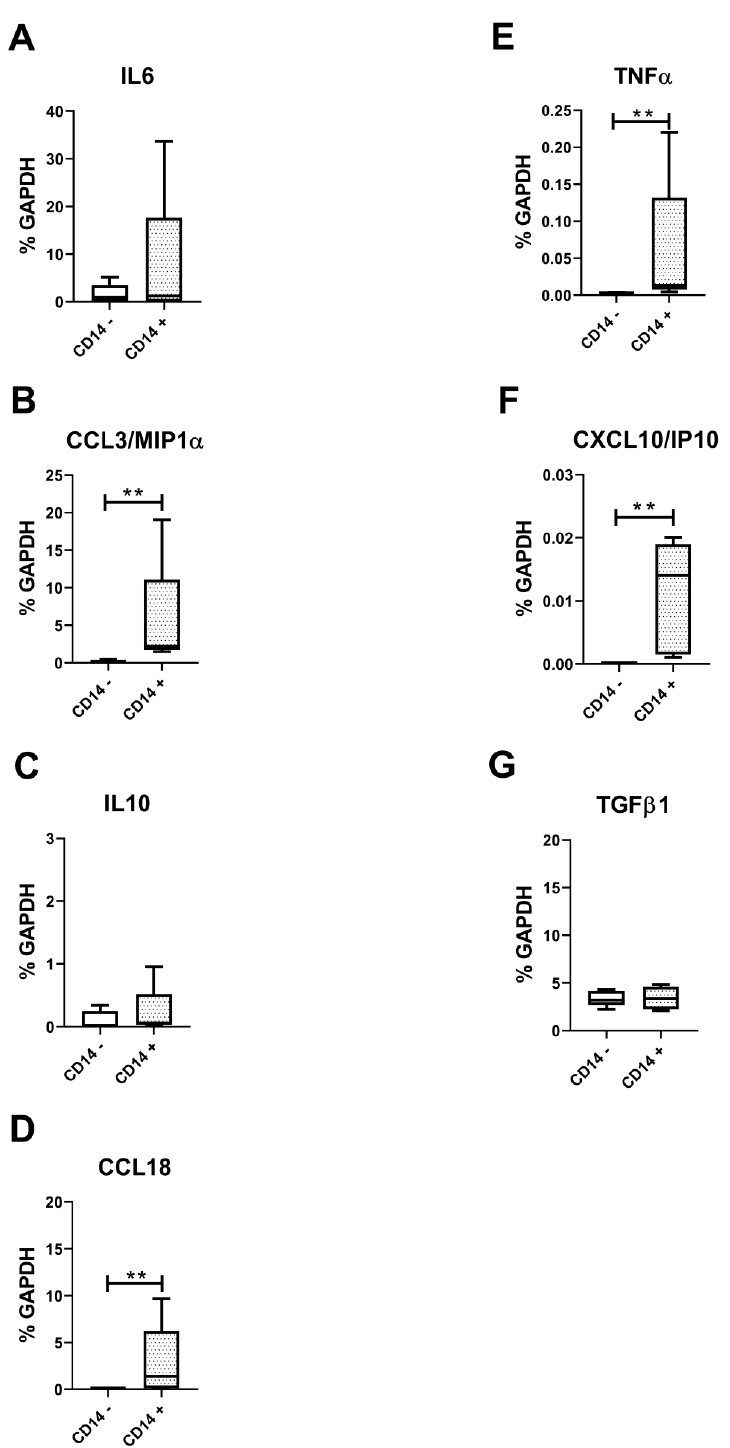
Figure 7. Evaluation of cytokines typical of synovial M1- and M2-like macrophages. ( A ) IL6, ( B ) CCL3 / MIP1 α , ( C ) IL10, ( D ) CCL18, ( E ) TNF α , ( F ) CXCL10 / IP10, ( G ) TGF β 1 typical cytokines of M1 and M2-type macrophages evaluated at the molecular level on pure CD14 negative (CD14 − ) and CD14-positive (CD14 + ) cells isolated from OA synovium ( n = 4). Data are expressed as percentage of GAPDH (housekeeping gene) and represented as box plots with median, minimum and maximum. Significant results among groups (** p < 0.01) were reported (Mann–Whitney U test was used to compare the two